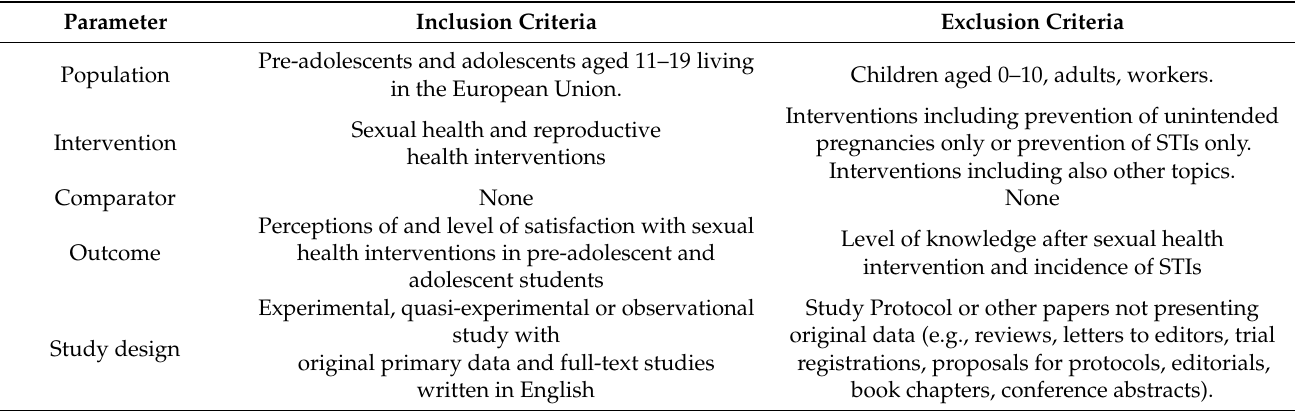
Table 1. PICOS inclusion and exclusion